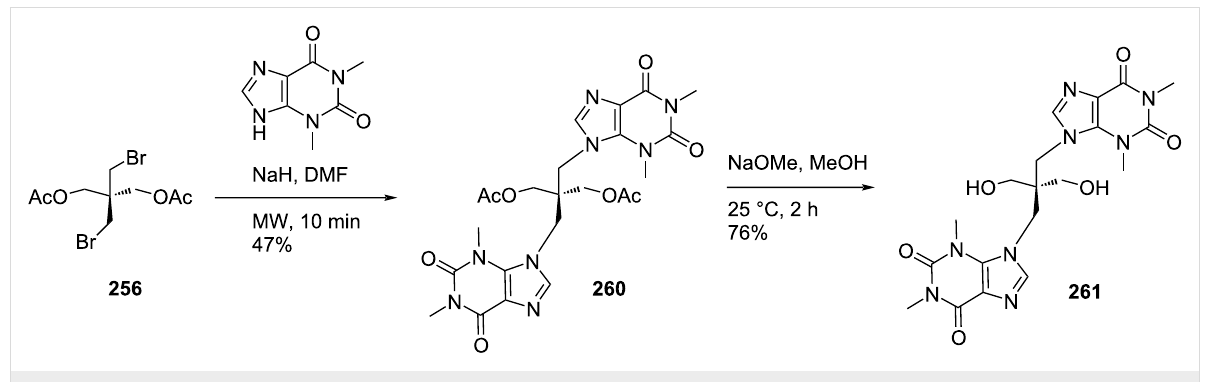
Scheme 68: Synthesis of acyclo double-headed nucleoside 261